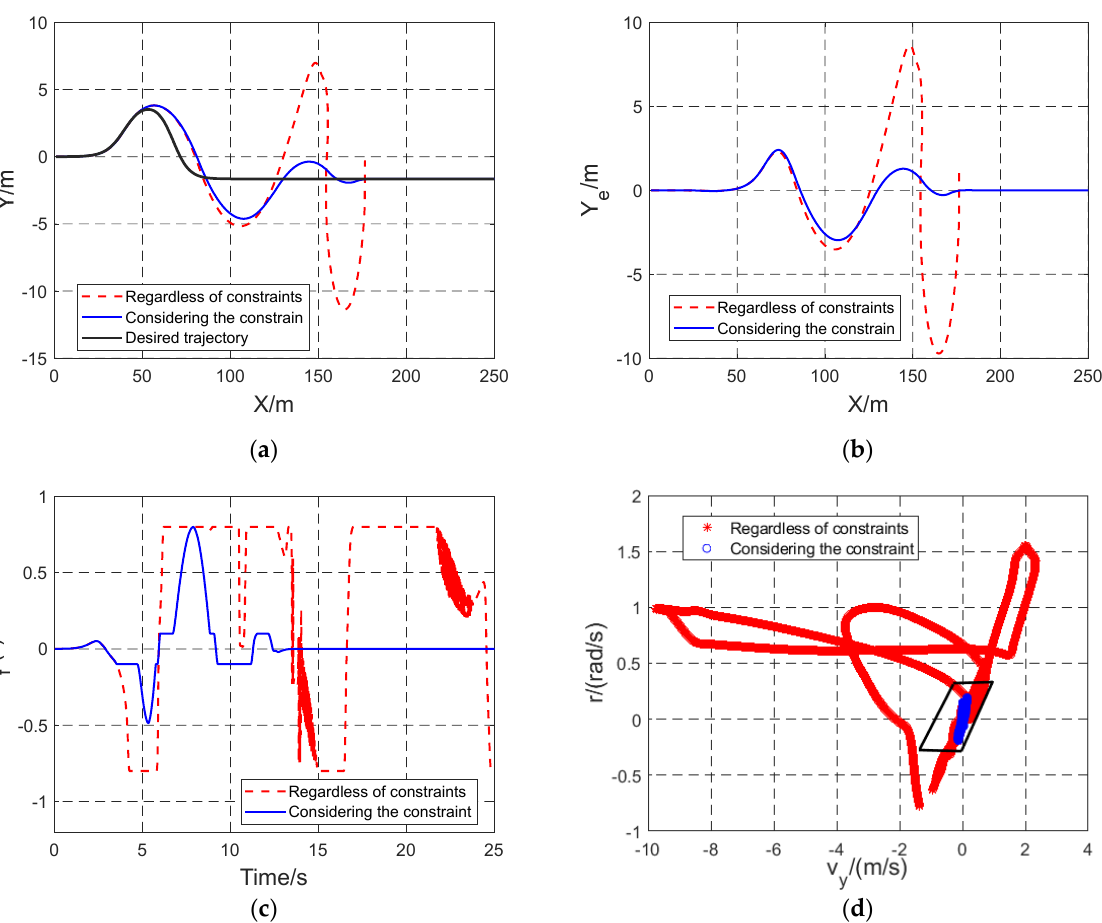
Figure 11. Simulation results of ice-covered pavement trajectory tracking at 50 km · h − 1 ; ( a ) Trajectory tracking results; ( b ) Lateral tracking error; ( c ) The front-wheel steering angle; ( d ) Comparison of the lateral velocity and yaw rate under whether slip constraints are applied. Table 2. RMSE of trajectory tracking error on ice-covered pavement.